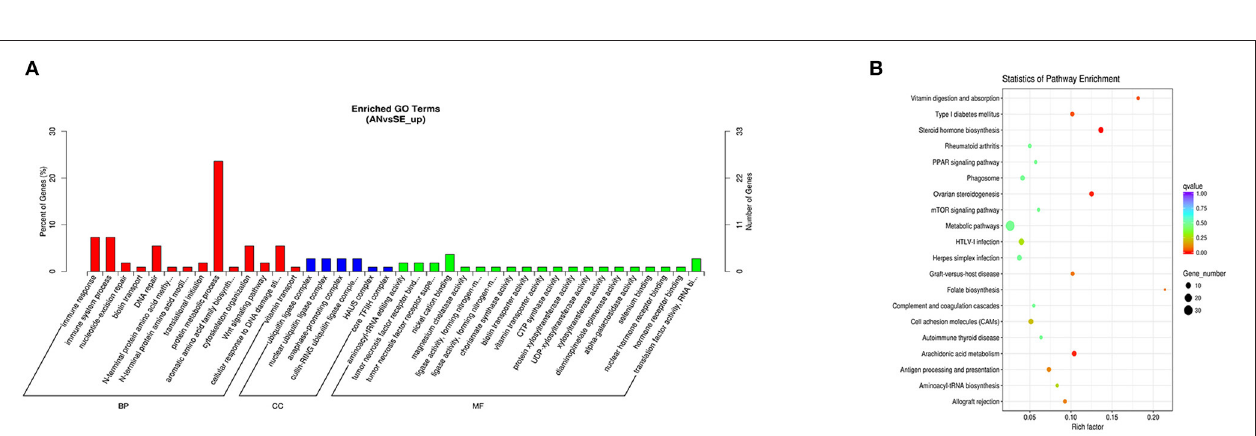
FIGURE 5 | Top annotated gene ontology (GO) terms (A) and Kyoto Encyclopedia of Genes and Genomes (KEGG) pathways (B) of upregulated DE mRNAs.